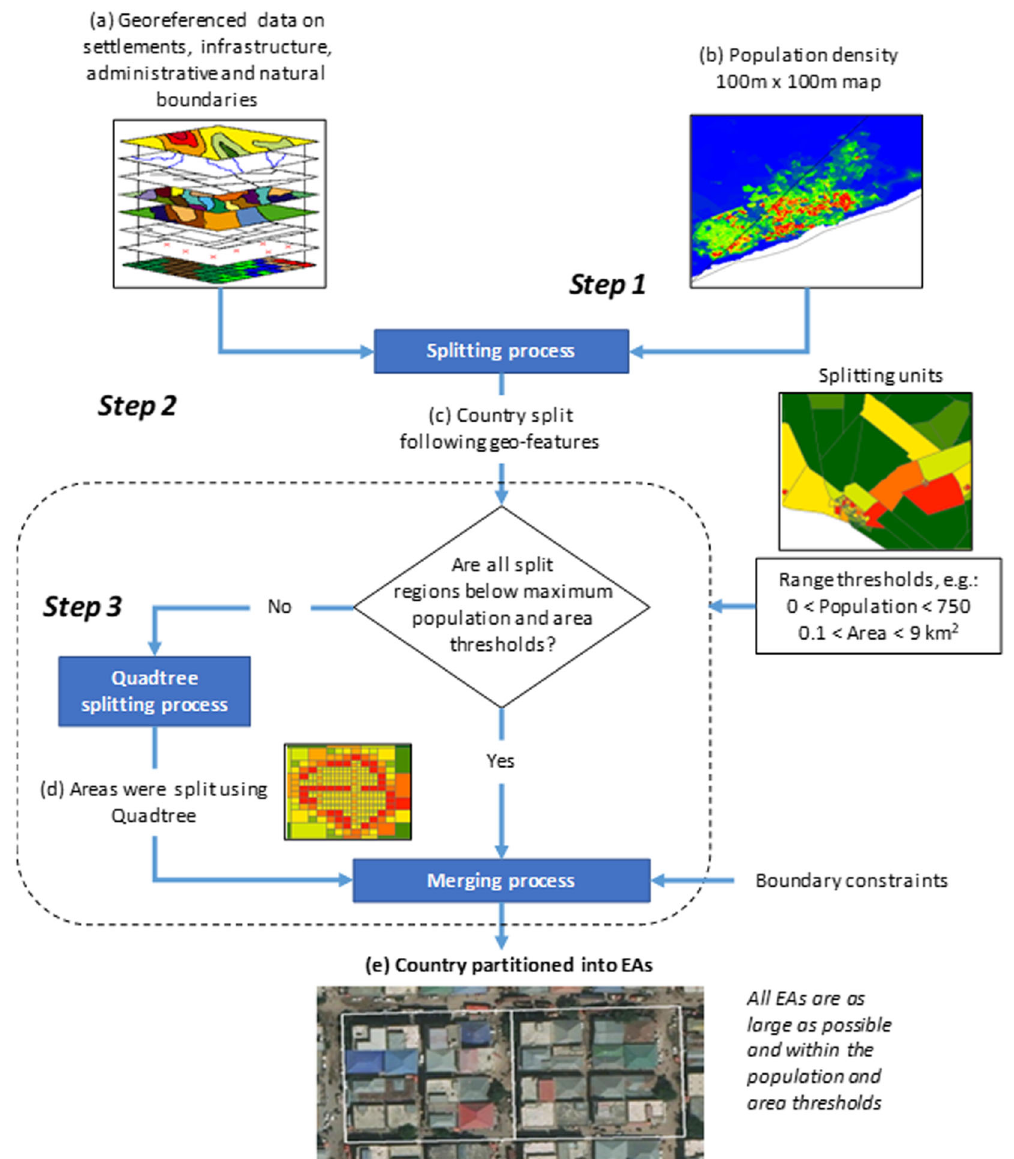
Fig. 1 Schematic diagram of our semi-automated EA delineation process. The fi rst step is to split the territory into regions as small as possible using georeferenced features such as administrative and natural boundaries (e.g. rivers, terrain), settlement location and outlines, and road and path networks ( a ). We then compute the estimated population in each region thus obtained (using a very high spatial resolution population density map) ( b ) and check if all regions have a population and an area below given thresholds. If not, we further split regions using the quadtree algorithm, until all regions are below the population and area thresholds. We then merge regions so that they exceed the given minimum area threshold and until they are as close as possible to but remain below the maximum population and area thresholds. The merging process does not merge regions across a set of speci fi ed boundaries (e.g. administrative boundaries and large rivers). The result is a partition of the country into EAs that follow visible boundaries, that are not across obstacles or administrative boundaries, and that comply with given ranges of population size and